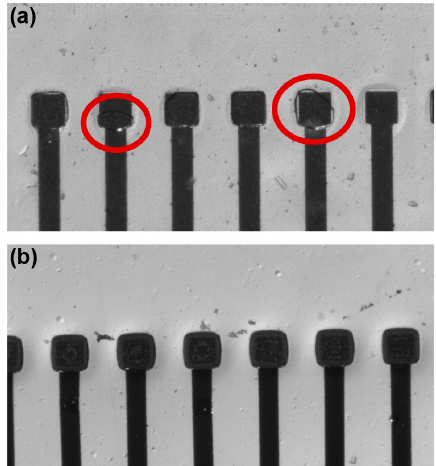
Figure 9. Optical microscope images for surface contact performance of plateau electrode. ( a ) An air bubble is trapped in the recessed electrode due to the hydrophobicity of the PDMS surface. ( b ) As there is no gap between the slide glass and electrodes, air bubbles are not seen on plateau electrodes.